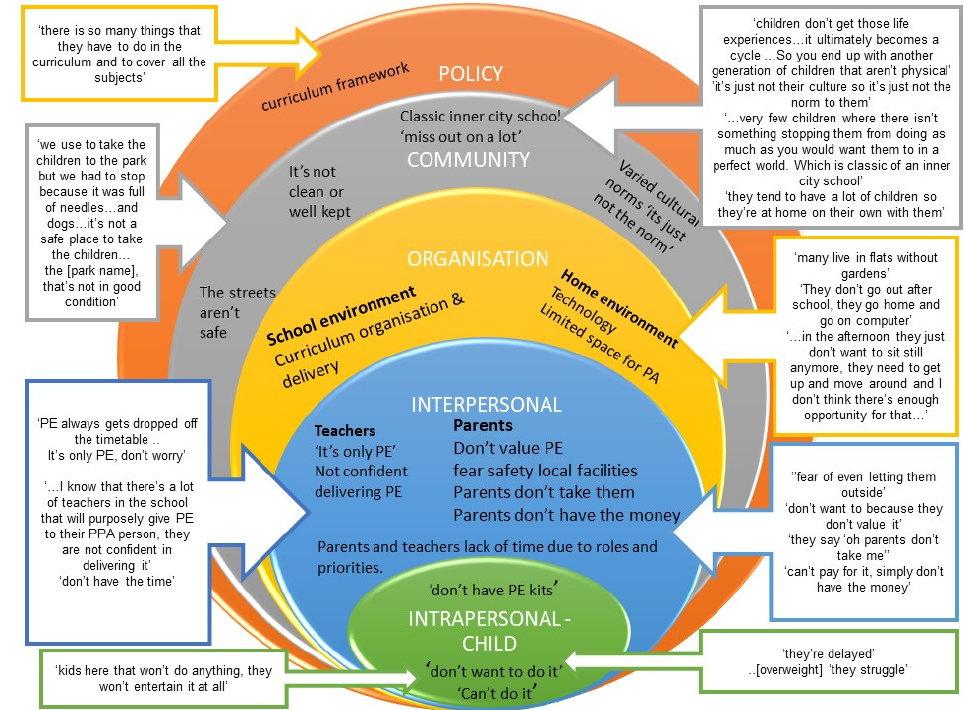
Figure 1. Teachers’ perspectives of barriers to FMS and physical activity in deprived and ethnically diverse